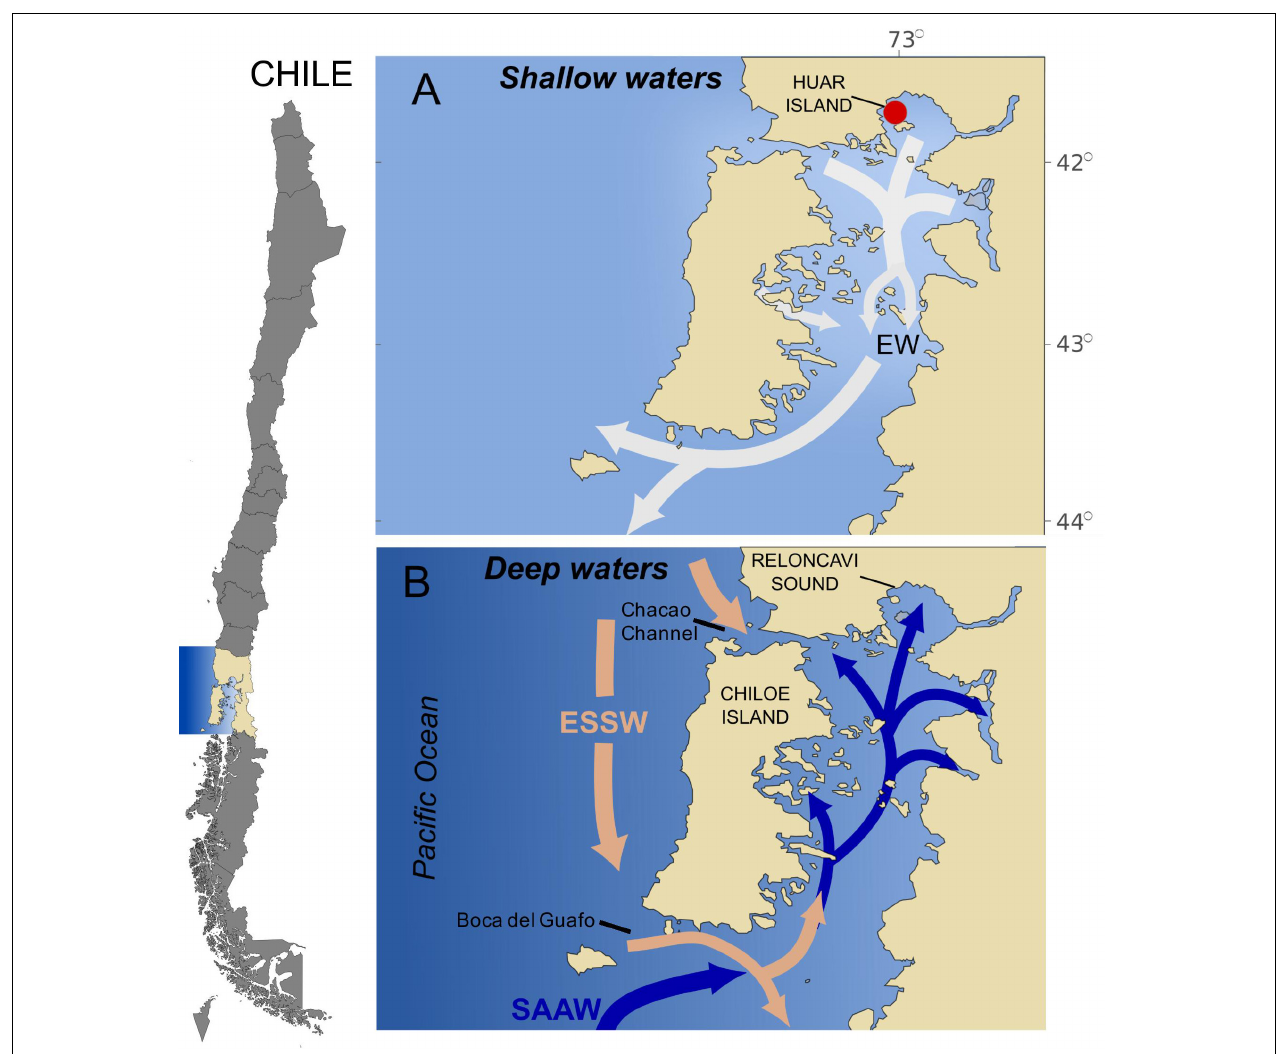
FIGURE 1 | Study area showing a schematic horizontal circulation model by layers (adapted from Silva et al., 1998). (A) Surface Estuarine Water EW (0– ∼ 30 m); (B) intermediate Subantarctic Water (SAAW) ( ∼ 30– ∼ 150 m) and deep Equatorial Subsurface Water (ESSW) ( ∼ 150 m to the bottom). The red circle shows the origin of the Pseudochattonella ARC 498